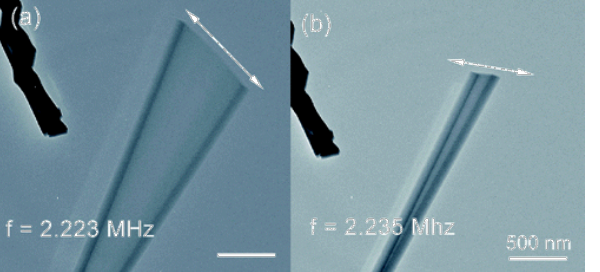
Figure 12. GaN nanowire in resonance, ( a ) in the x 3 direction and ( b ) in the x 2 direction, reprinted with permission from C.-Y. Nam, P. Jaroenapibal, D. Tham, D. E. Luzzi, S. Evoy, J. E. Fischer, Diameter dependent electromechanical properties of GaN nanowires , Nano Letters 6 (2006) 153–158 [38] Copyright (2006) American Chemical